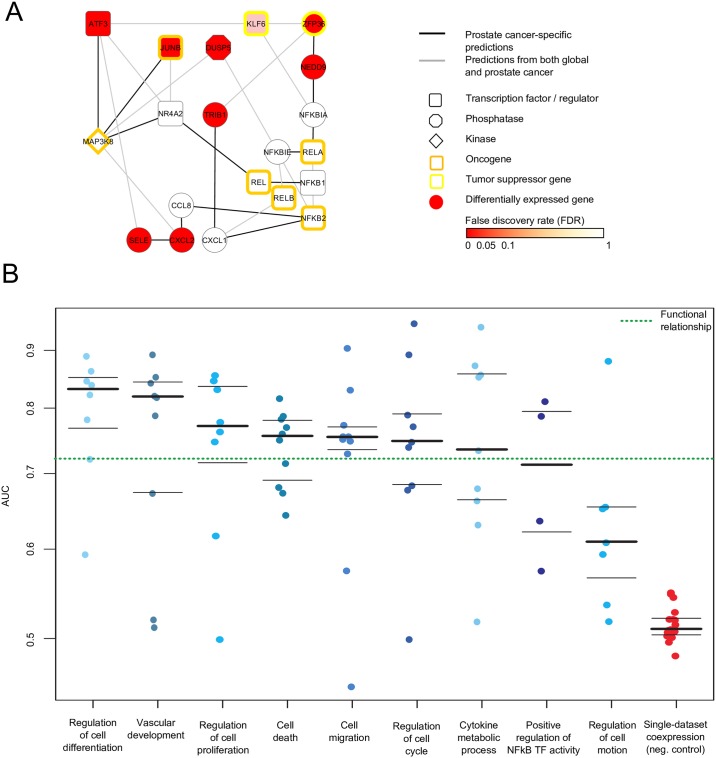
Context-specific functional networks for prostate cancer and the NFκB pathway.(A) Comparison between prostate cancer-specific and global (non-context-specific) predicted functional associations of 20 genes from our predicted NFκB pathway (Fig 2), including five NFκB genes (NFκB1, NFκB2, REL, RELA, RELB), two NFκB inhibitors (NFκBIA, NFκBIE), eight differentially expressed genes in lethal versus indolent prostate cancer (Table 1), and five additional connecting genes from our predicted NFκB pathway (MAP3K8, NR4A2, CCL8, CXCL1, KFL6) (Fig 2). We predicted 14 high-confidence functional associations between these genes that were exclusively context-specific to prostate cancer (black lines), along with 15 additional high-confidence (but not prostate cancer-specific) functional associations (grey lines). (B) Performance (AUC values) of the nine trained context-specific functional networks after performing a 10-fold gene-holdout-based cross-validation of each of the context-specific networks compared to a non-context-specific global functional network and, as a negative control, co-expression networks from 18 curated prostate cancer specific single expression data sets (S1 Table) revealed that the context specific networks are generally more accurate than the global functional network, while all trained networks outperform the negative control.